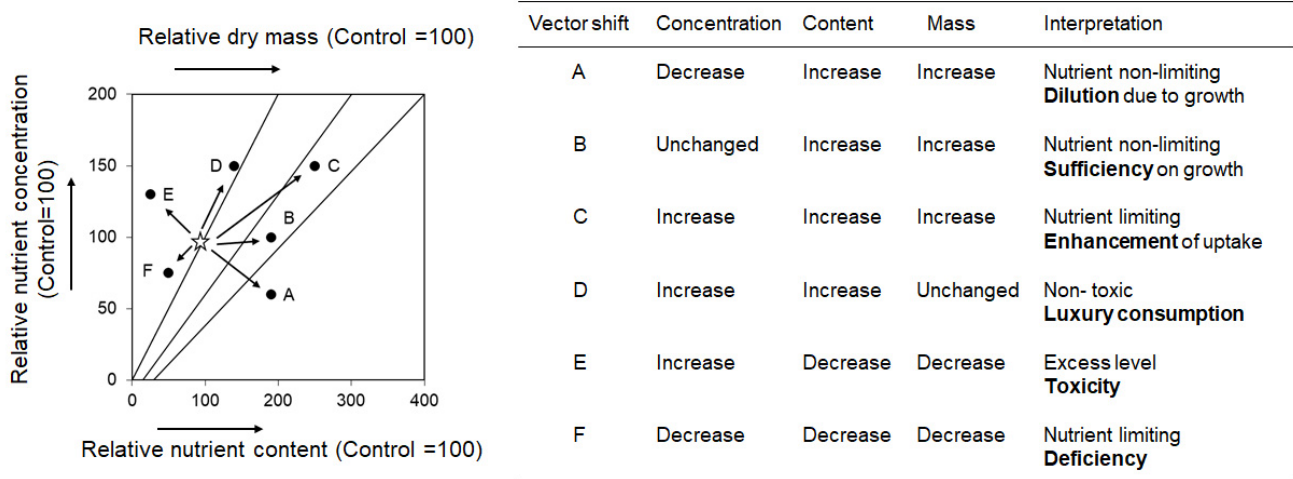
Figure 1. Graphical illustration interpreting the changes in dry mass content and concentrations of nutrients grown under three different treatments. The content isograms represent combinations of dry mass and concentration required at a constant content per unit dry mass. The arrows indicate the direction in which each interpretation holds (adapted from Hasse and Rose [24], Scagel [25], and Kayama and Yamanaka [30]). The star located at the left section of this fi gure represents the reference point, and the dry mass, concentration, and contents of nutrients were obtained from the control treatment.